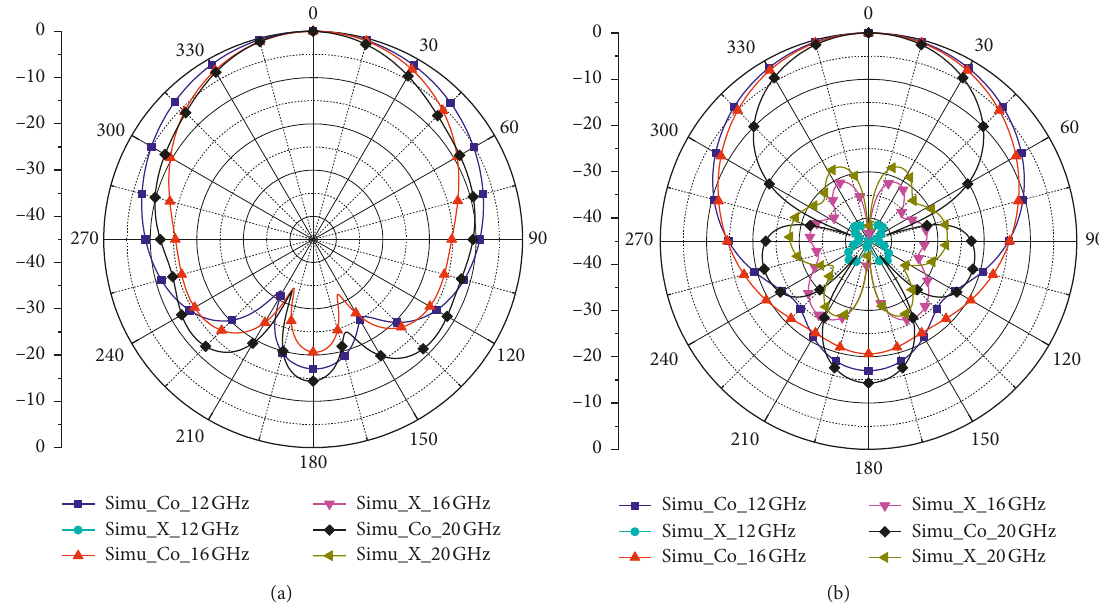
Figure 6: The simulated co- and cross-polarization radiation patterns of the proposed antenna element at 12 GHz, 16 GHz, and 20 GHz. (a) E-plane (b) H-plane. Table 2: Comparison among proposed and reported antenna elements.